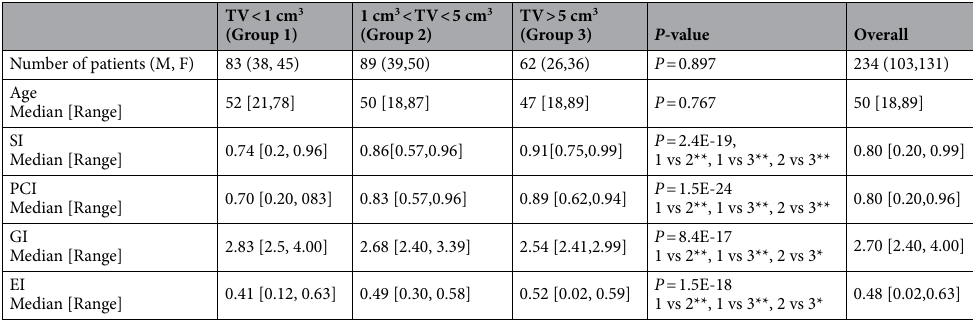
Table1. Patient characteristics and summary of dose planning indices of this